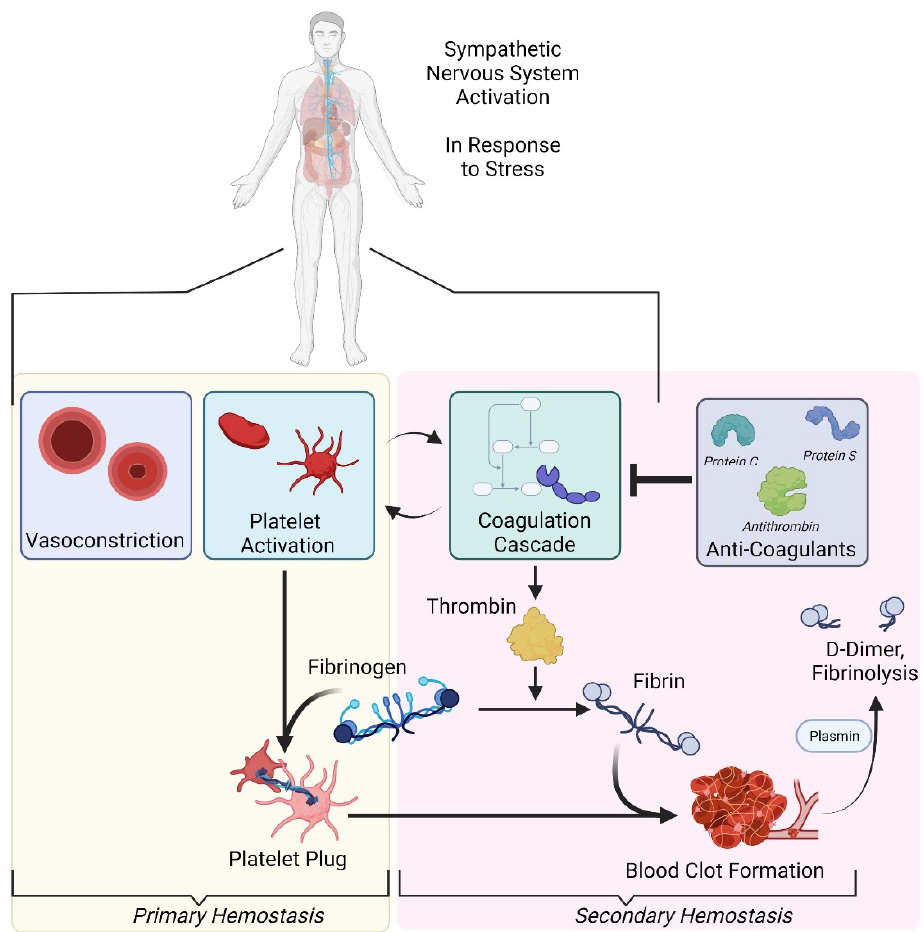
Figure 1. A visual depiction of hemostasis and the hemostatic response. The image was created with BioRender.com (accessed on 27 September 2021).